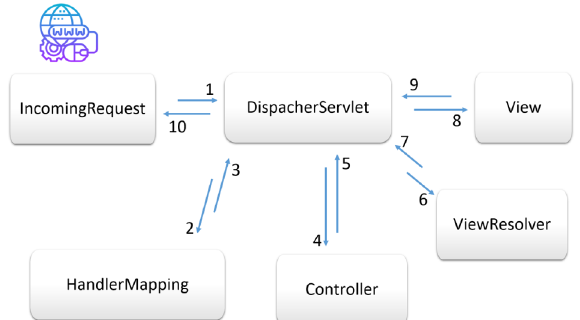
Figure 6: Flow of RESTful call in MVC-framework. Adapted from Mohmmad Amr, Grails MVC Tutorial, 2014 (https://javabeat.net/grails-mvc-tutorial/).